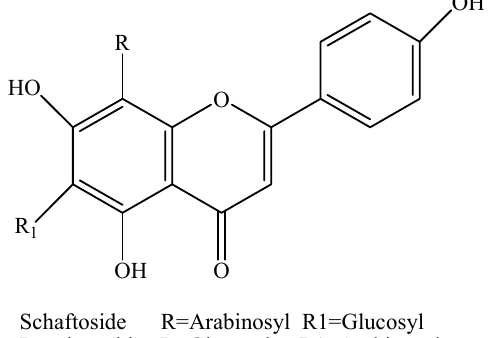
Figure 1. Structures of nematicidal flavone- C -glycosides isolated from Arisaema erubescens tubers.